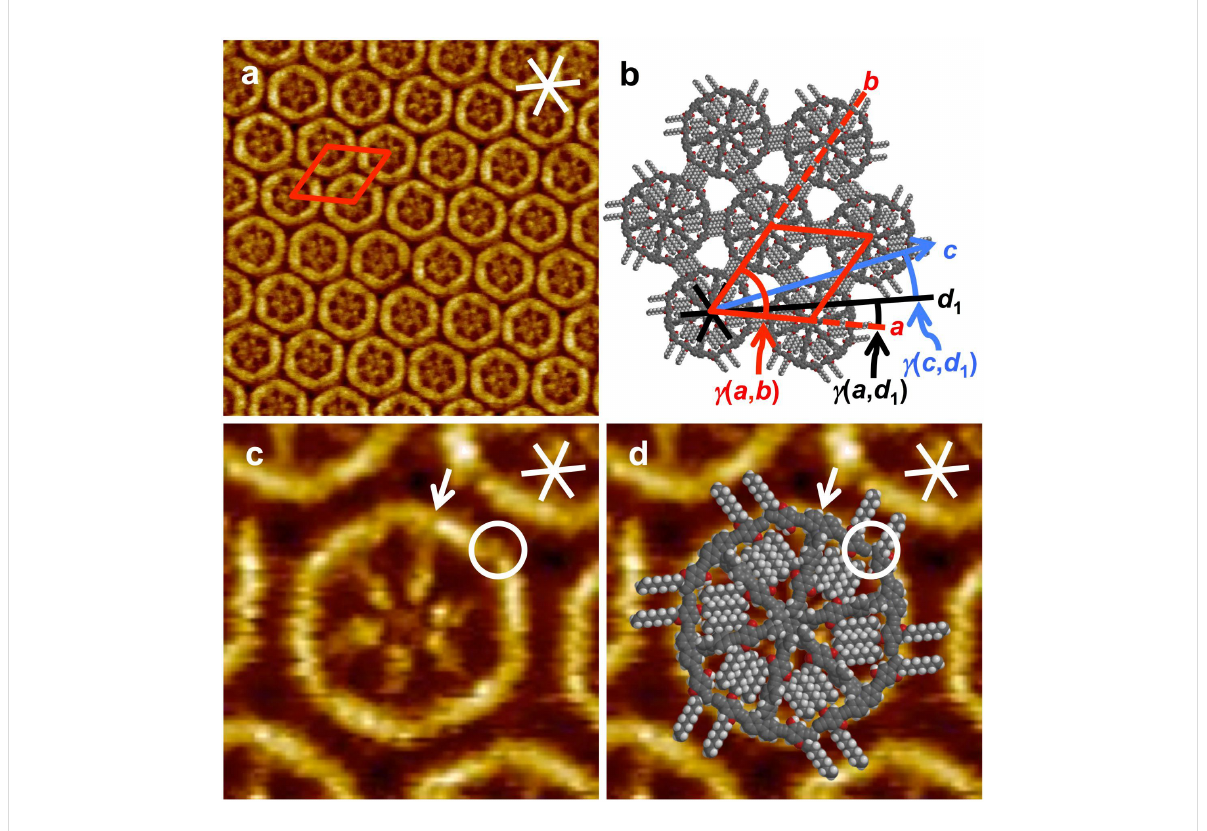
Figure 2: (a)–(d) STM images, a molecular, and a supramolecular model of 1 at the OA/HOPG interface. (a) STM image (40.9 × 40.9 nm 2 , V S = − 1.6 V, I t = 5 pA) and (b) supramolecular model: The MSW precursors self-assemble into a 2D-crystalline pattern of densely packed molecules. A hexagonal unit cell (red lines) of a = b = 6.7 ± 0.2 nm, γ ( a , b ) = 60 ± 2° is indexed. The unit cell vector a is aligned relative to one of the three HOPG main axis directions (black, white lines), d 1 , with γ ( a , d 1 ) = 9 ± 2°. The direction of the backbones, c , as defined by two spokes (and shown by the blue arrow), is γ ( c , d 1 ) = 12 ± 2°. (c) and (d): High-resolution STM image (9.3 × 9.3 nm 2 , V S = − 1.6 V, I t = 4 pA), (c) without and (d) with a superimposed molecular model. The white arrows indicate one representative carbazole unit that connects a rim segment with a spoke. The white circles indicate one representative kink of the brightly appearing hexagon, and the corresponding region in the molecular model where two adjacent rim segments meet. In other words, the kinks do not correspond to the carbazole units, but originate from adjacent rim segments that align in a characteristic fashion. Both STM images were acquired from a 2 × 10 − 6 M solution of 1 in OA, and the sample was thermally annealed for 30 s at 70 °C prior to